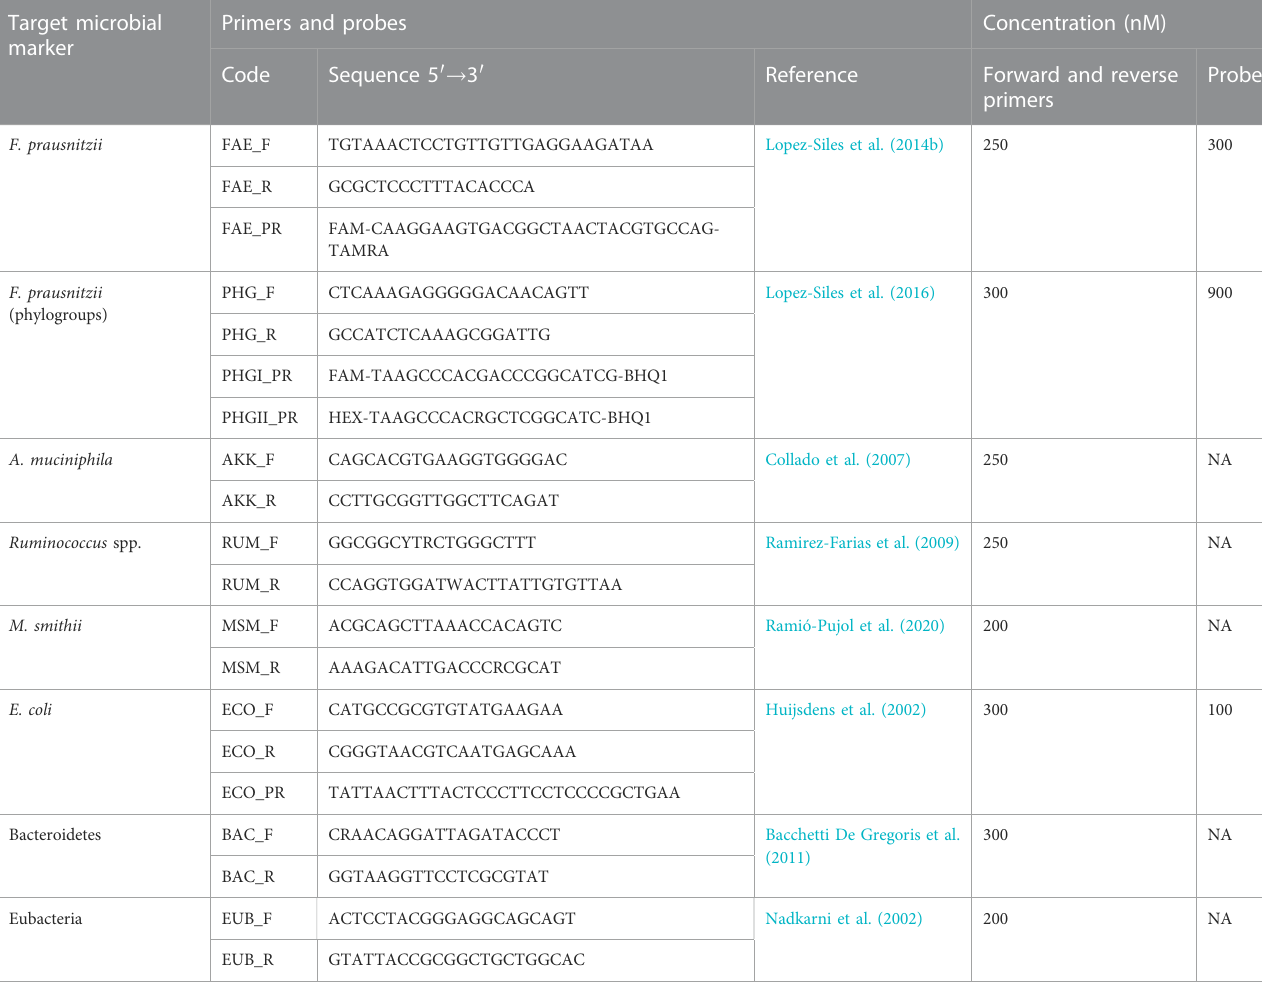
TABLE 2 16S rRNA-targeted primers and probes sequences used in this study. The fl uorophore and the quencher of the probes are also shown. NA, not applicable. Target microbial marker